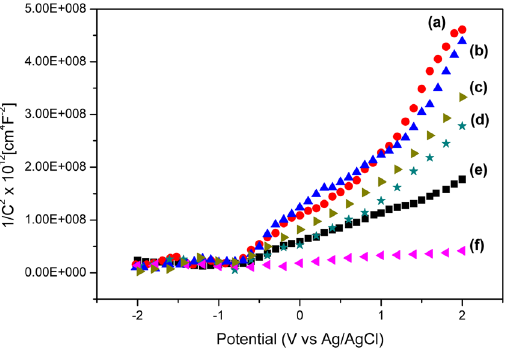
Figure 11. Mott-Schottky plots of ( a ) platelet-like BiVO 4 , ( b ) MIL-125(Ti), ( c ) 3-2 Bi:Ti (PM), ( d ) 1–1 Bi:Ti, ( e ) 2–3 Bi:Ti and ( f ) 3-2